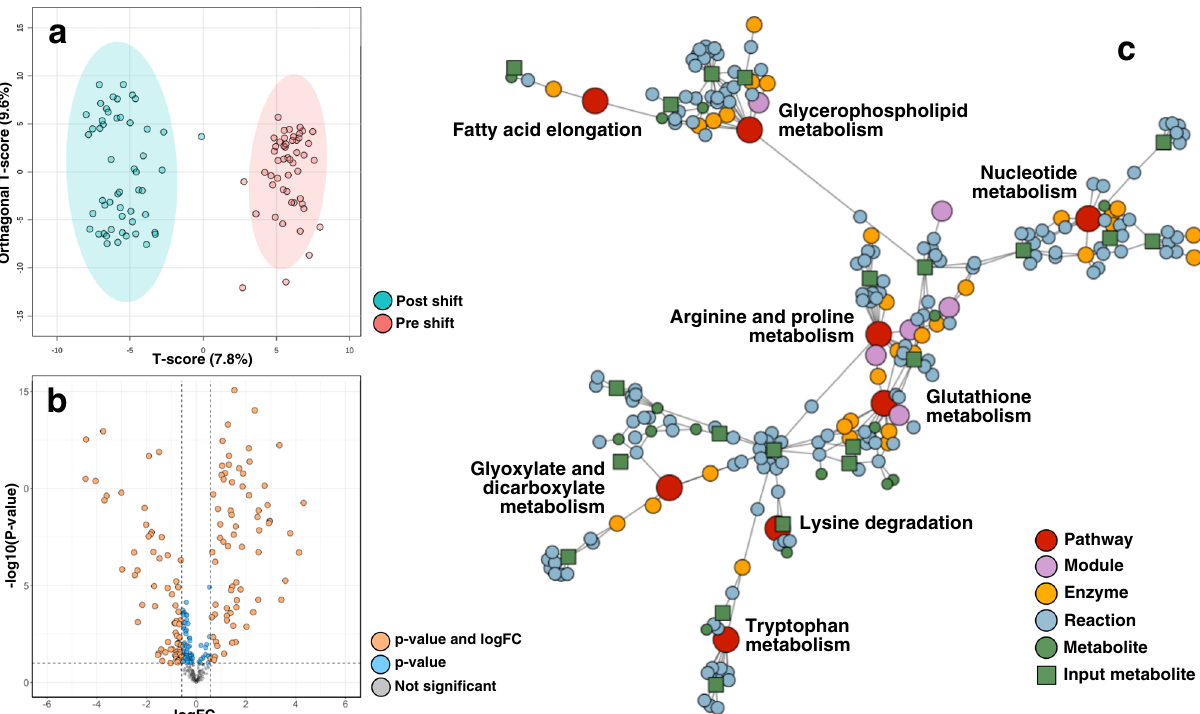
Fig. 2 Overview of metabolomic changes across the diauxic shift. a Diauxic shift phase classi fi cation and 95% con fi dence intervals using orthogonal partial least squares discriminatory analysis (oPLS-DA) with identi fi ed peaks as features. b Volcano plot showing differentially expressed metabolites across the shift (raw p -value < 0.1 and fold-change > 1.5, linear model). c Diffusion based topological enrichment using FELLA with signi fi cantly enriched pathways in red (FELLA p -score <